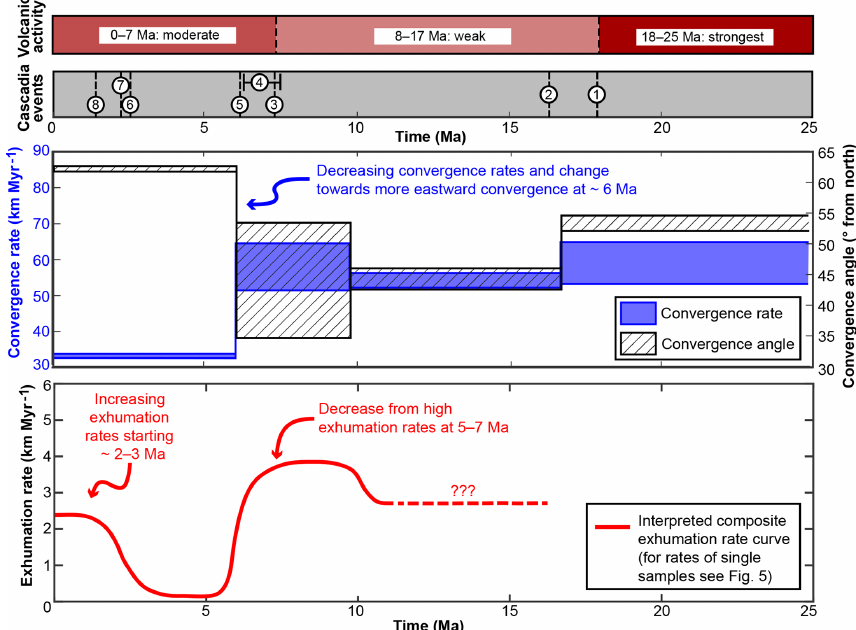
Figure 8. Summary of volcanic activity, tectonic and climatic events, and convergence rate and angle at the Cascadia Subduction Zone in comparison with our interpreted exhumation rates for the past 25Myr. Exhumation rates are limited to the time interval covered by our thermochronometric ages (0–11Ma). The curve depicts the interpreted evolution of exhumation rates based on the modeling results shown in Fig. 5 (see text for details). Volcanic activity after du Bray and John (2011). Tectonic and climatic events are (1) the start of exhumation of the Olympic Mountains (Brandon et al., 1998), (2) the onset of uplift of the Oregon Coast Range (McNeill et al., 2000), (3) rotation in the stress field (Priest, 1990), (4) faster uplift in the Oregon Coast Range (McNeill et al., 2000), (5) Pacific-wide plate reorganization (Wilson, 2002), (6) the onset of North American glaciation (Haug et al., 2005), (7) the onset of glaciation within the Olympic Mountains (Easterbrook, 1986), and (8) a change in the deformational style of the offshore accretionary wedge (Flueh et al., 1998). Convergence rate and angle from Doubrovine and Tarduno